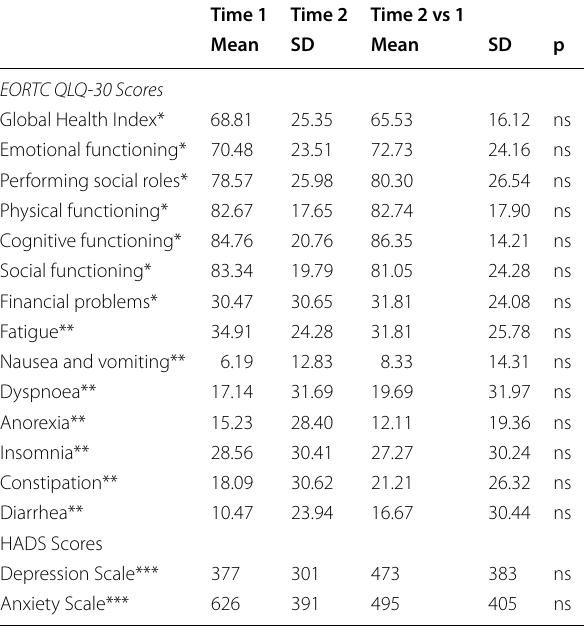
EORTC QLQ-30 European Organisation for Research and Treatment of Cancer- Quality of Life Questionnaire-C30, ns non-statistically significant * Score range 0–100, higher scores indicating better performance ** Score range 0–100, higher scores indicating more severe symptom *** Score range 0–21, higher scores indicating more sever